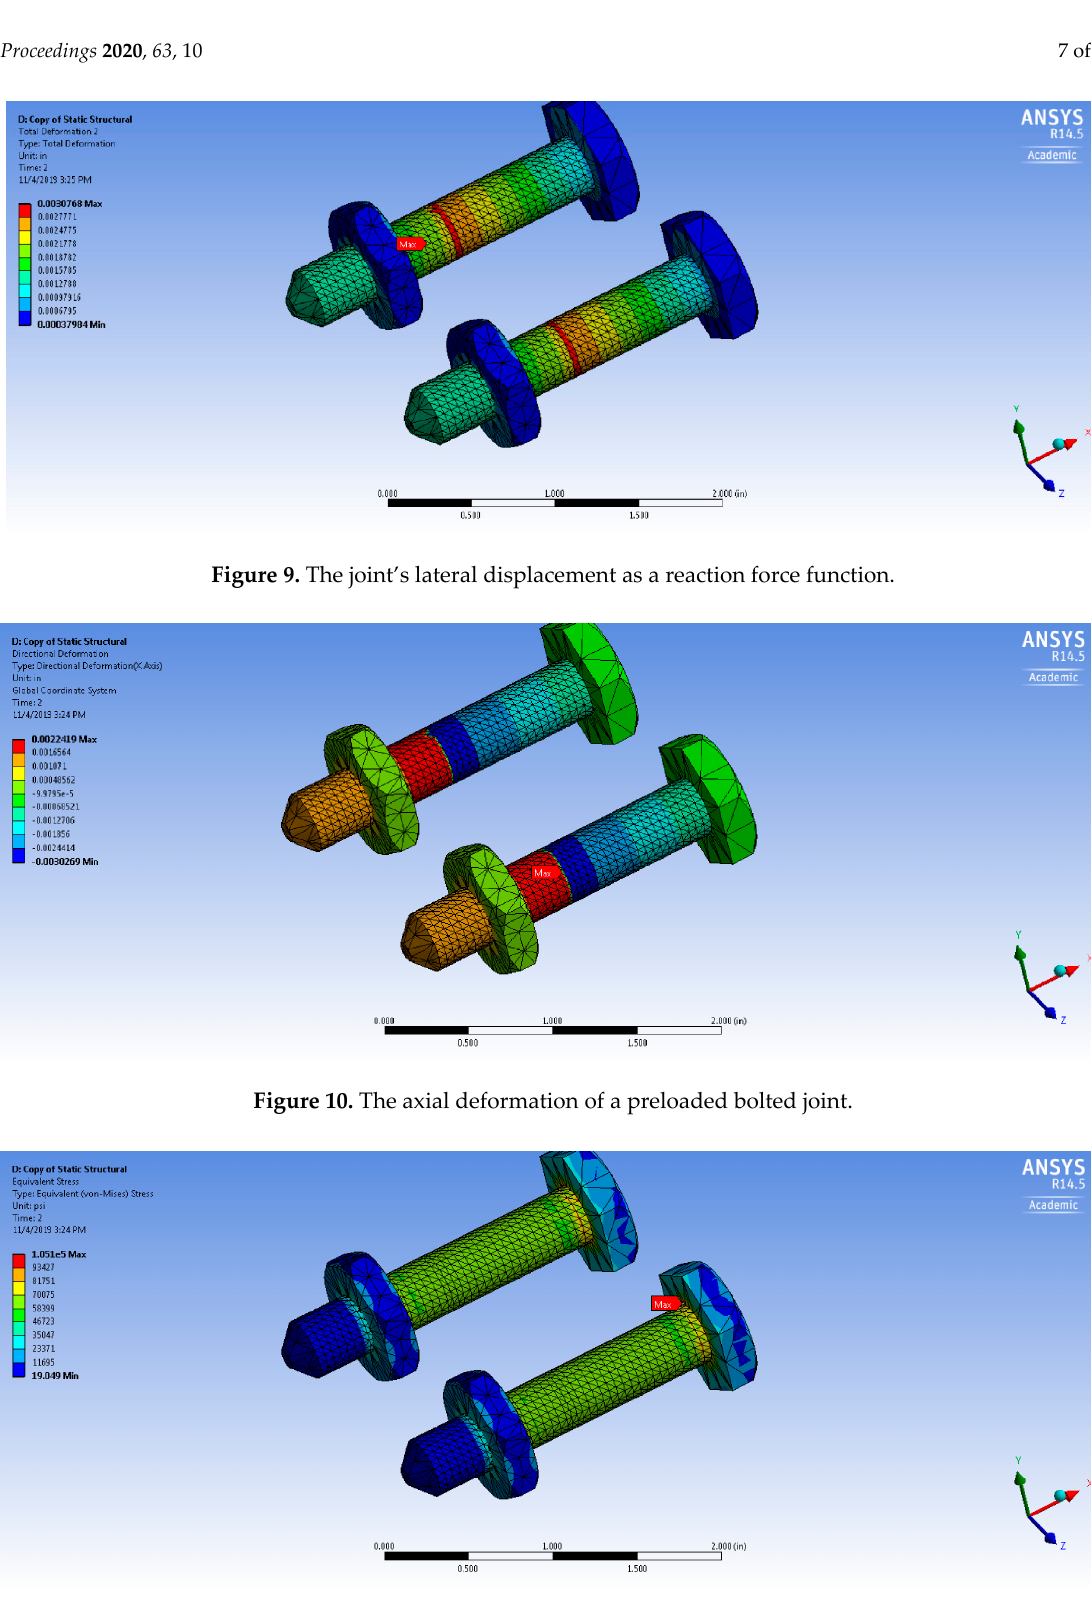
Figure 11. The equivalent stress (von Mises) of a preloaded bolted